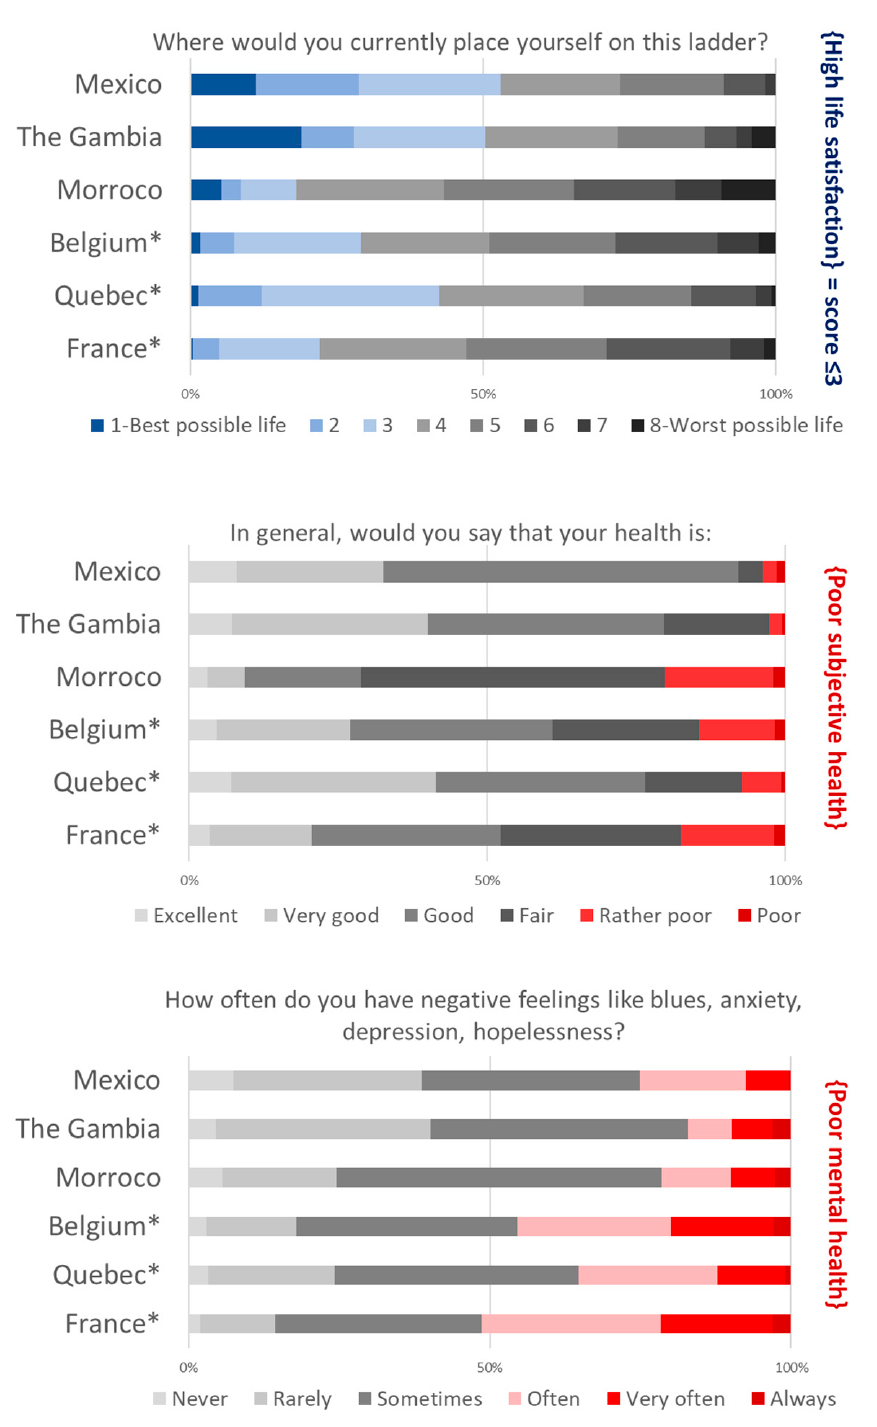
Figure 2. Three indicators of teachers’ general wellbeing: life satisfaction, subjective health, mental health, 2021 International Barometer of Education Personnel’s Health and Wellbeing (I-BEST). (* Weighted statistics taking into account gender and teaching level + age group in France and Bel- gium).